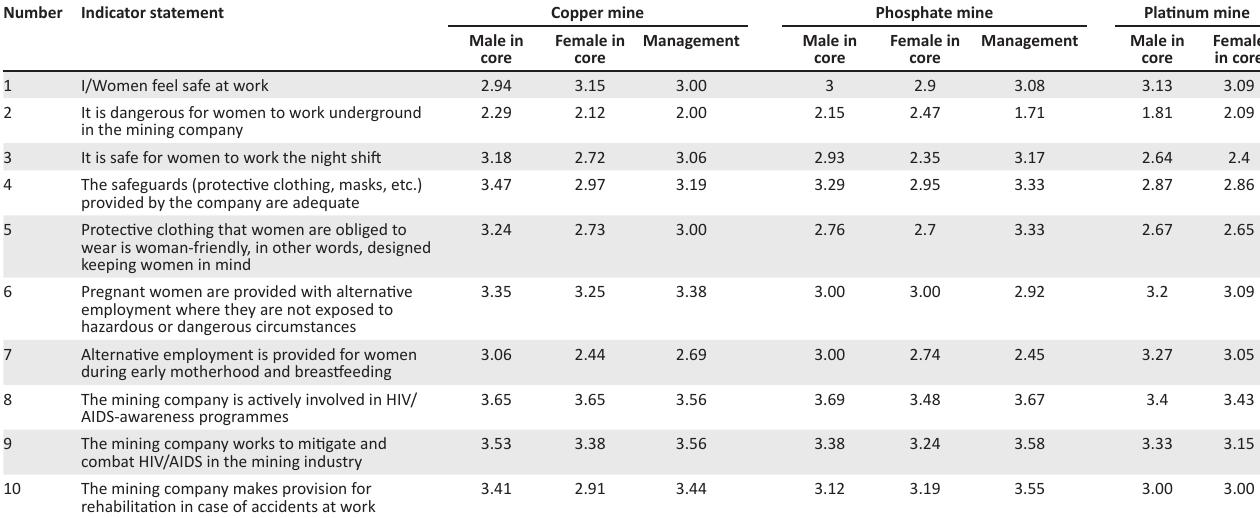
TABLE 3: Participants’ perceptions regarding health and safety in the workplace. Number Indicator statement